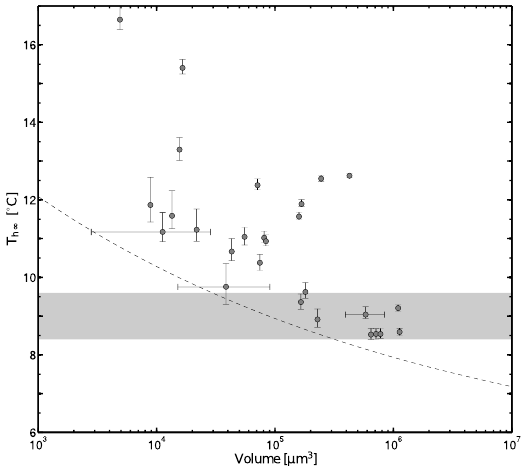
Figure 8. Results from stalagmite M2. T h ∞ and inclusion volumes are calculated from T hobs and r (5.1 ◦ C) and are shown as grey dots. The errors in T h ∞ and the inclusion volume V resulting from an er- ror in bubble radius determination of ± 0.25µm are indicated. For the sake of legibility, not all volume error bars are shown. See Fig. 4 for a more complete illustration of the errors. The expected forma- tion temperature of the analysed stalagmite section is indicated by the grey bar. The dashed curve depicts the boundary below which no bubble can be nucleated, for details refer to Sect.